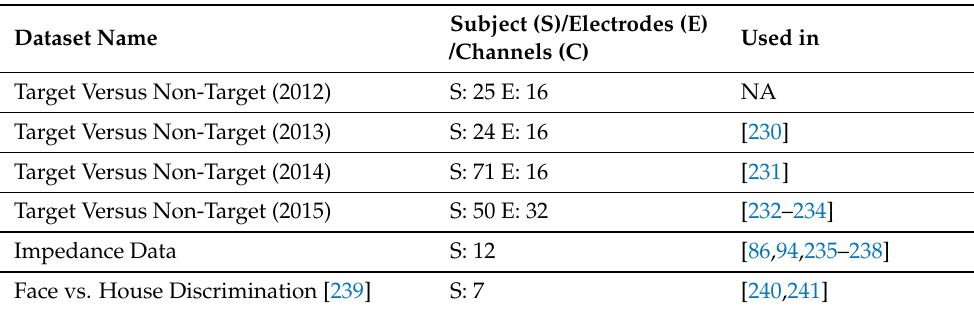
Table 7. A table of different types Event-Related Potential (ERP) datasets in BCI. These datasets are collected from [229].